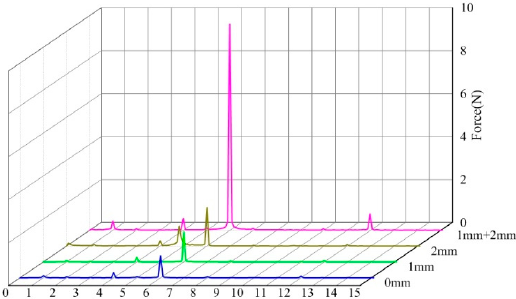
Figure 31. Spectrum of radial force for different tip clearances [76].